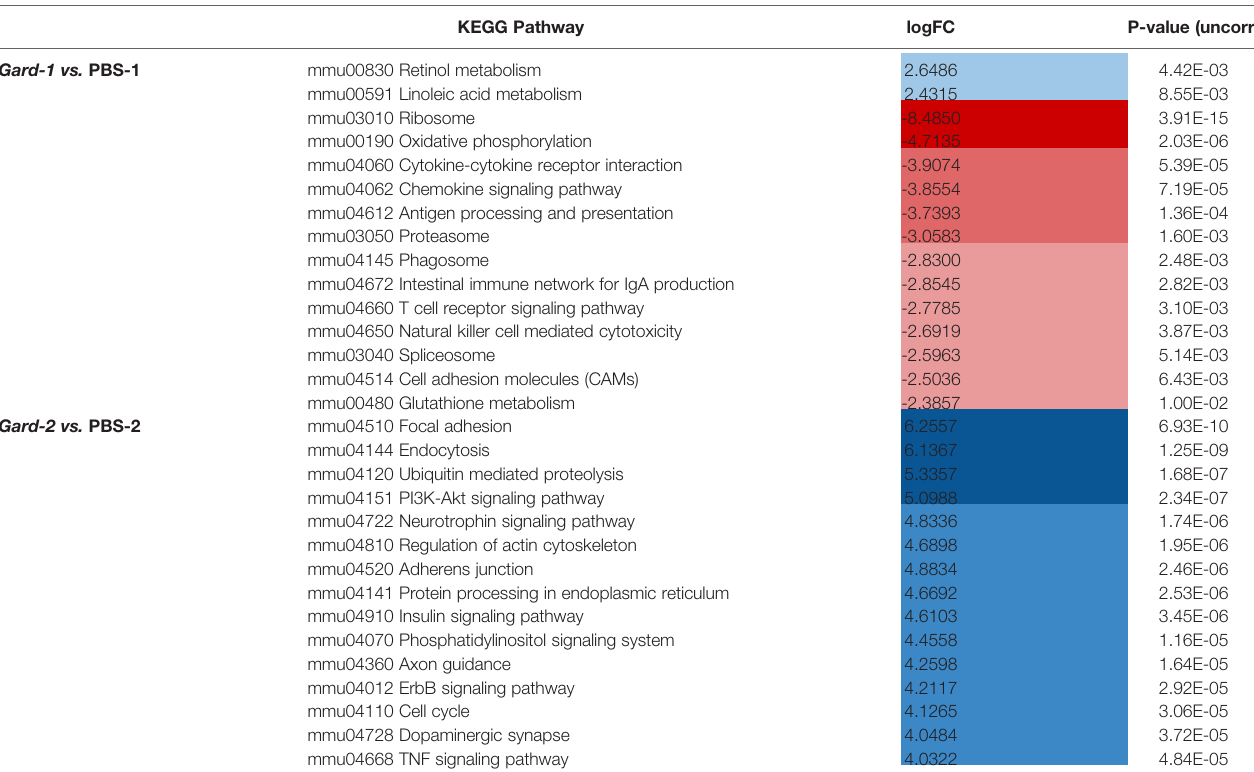
TABLE 1 | Host Pathways Most Affected by Gardnerella Bladder Exposures. KEGG Pathway